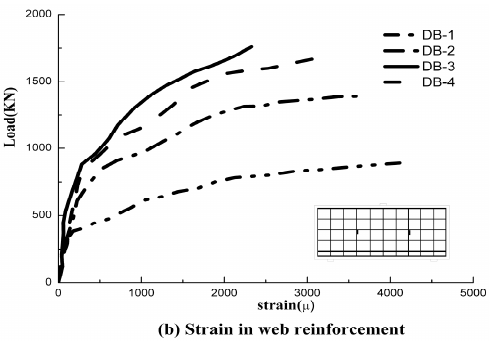
Figure 10. Applied load against strain. ( a ) Strain in longitudinal reinforcement; ( b ) Strain in web